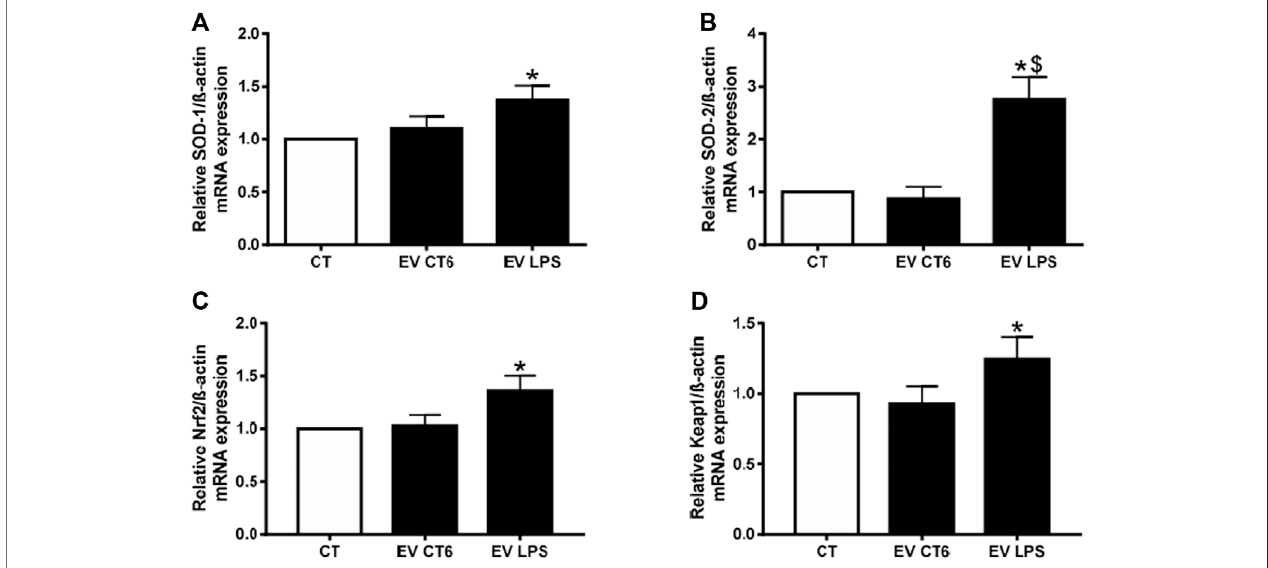
FIGURE 9 | EV-LPS increase antioxidant marker gene expression in smooth muscle cells. MOVAS-1 cells were incubated with EVs-derived RAW cells for 24 h. Gene expression of (A) SOD-1, (B) SOD-2, (C) Nrf2, and (D) Keap1 wasthen quanti fi ed by quantitative real-time PCRand normalized tothat of the housekeeping gene ß-actin. Data are expressed as the mean ± SEM of four independent experiments performed in triplicate ( n = 4). * p < 0.05 vs . CT, $ p < 0.05 vs . EV-CT, Mann-Whitney test. EV-CT: EV-derived from untreated macrophages, EV-LPS: EV-derived from LPS-EK-treated macrophages.